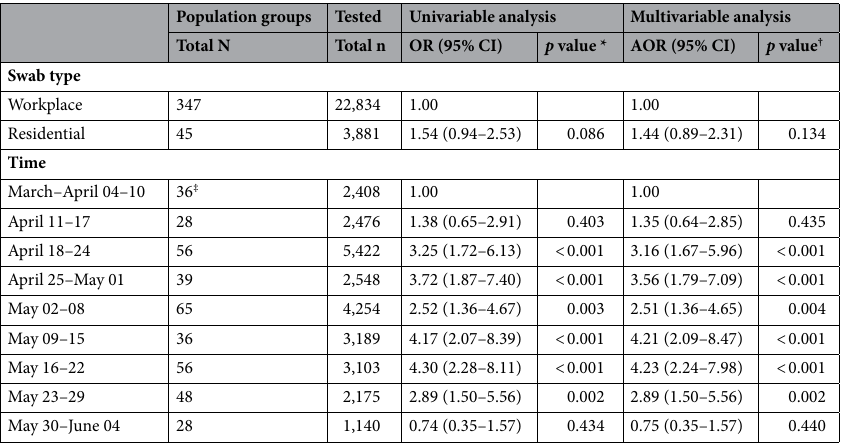
Table 4. Meta-regression results to identify associations with SARS-CoV-2 PCR positivity in the random testing campaigns conducted in workplaces and in residential areas, up to June 4, 2020. AOR adjusted odds ratio, CI confidence interval, OR odds ratio, PCR polymerase chain reaction. *Predictors with p value ≤ 0.1 were eligible for inclusion in the multivariable analysis. † Predictors with p value < 0.05 in the multivariable model were considered statistically significant. ‡ Includes 4 populations tested in